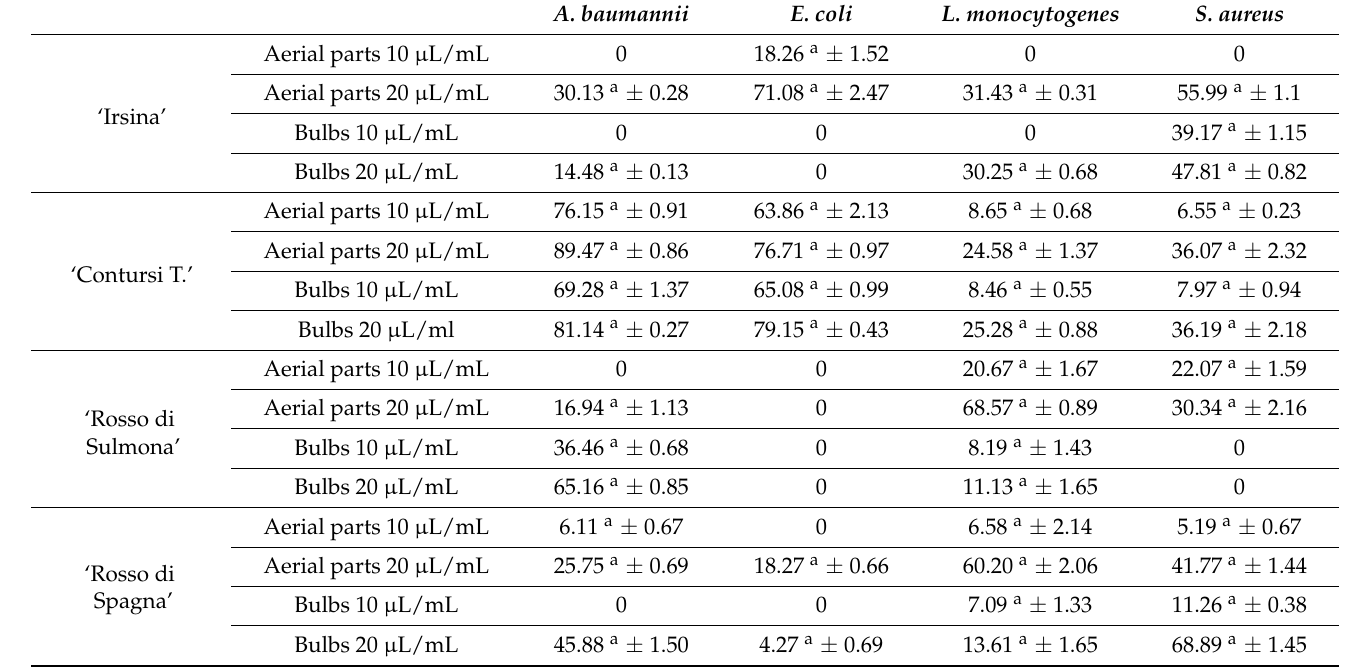
Table 7. Inhibitory activity of the EOs from the cultivars of A. ampeloprasum var. holmense and A. sativum on the cell metabolism of the pathogenic strains within the